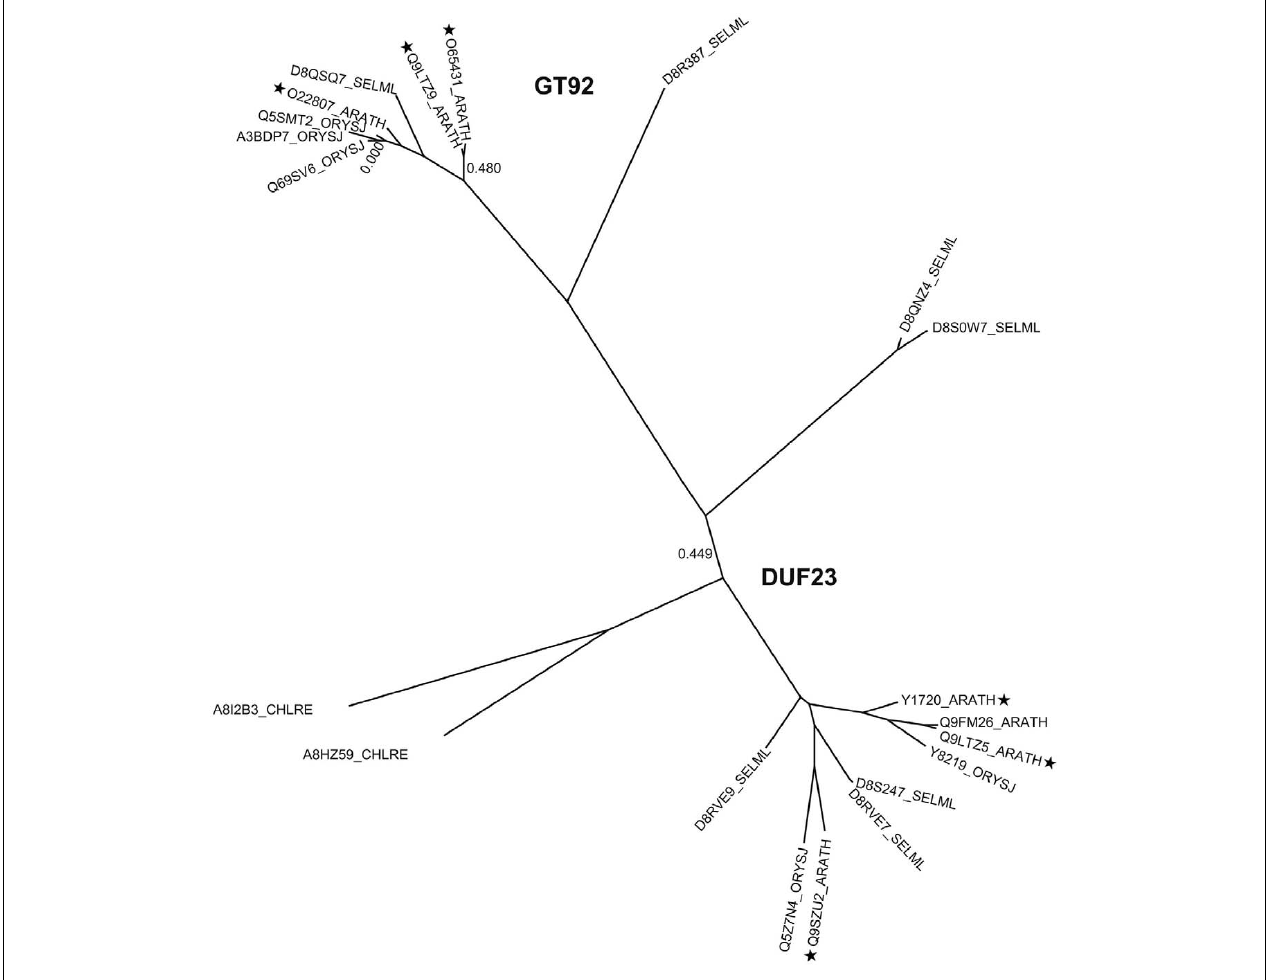
approximate likelihood-ratio test (aLRT).The tree was generated using http://www.phylogeny.fr (Dereeper et al., 2008). Following sequences A8HZ53 and A8I2B1 were omitted from the tree due to sequence mistakes, mainly intron/exon border malpredictions. Asterisks indicate the selected sequences of the multi alignment displayed in FigureA4